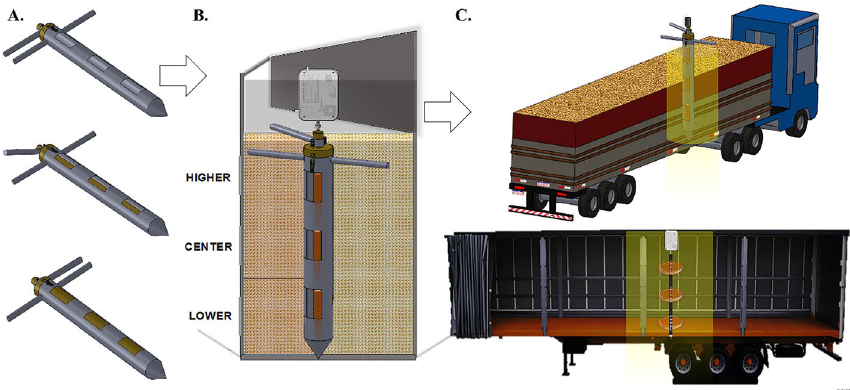
Figure 2. Grain sampling tube ( A ). Representation of the grain mass profile (higher, center and lower positions) and the monitoring system ( B ). Representation of the monitoring system and grain transportation ( C